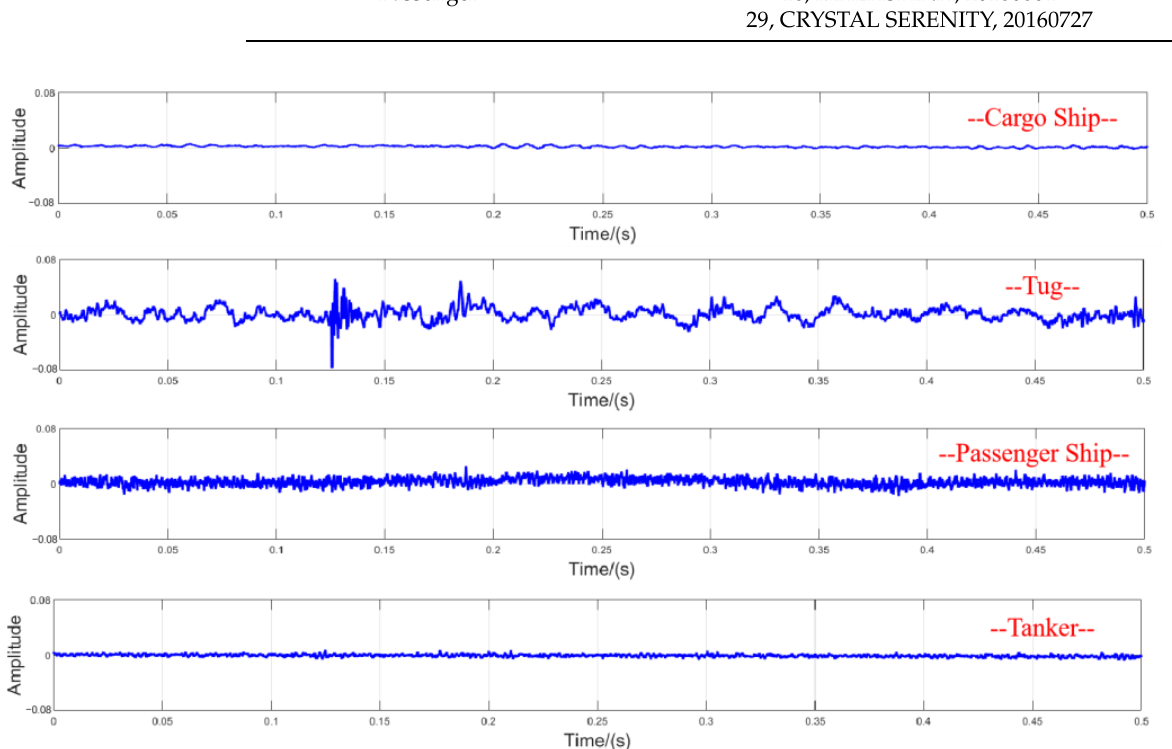
Figure 8. Waveform of ship’s original signal in DeepShip dataset.